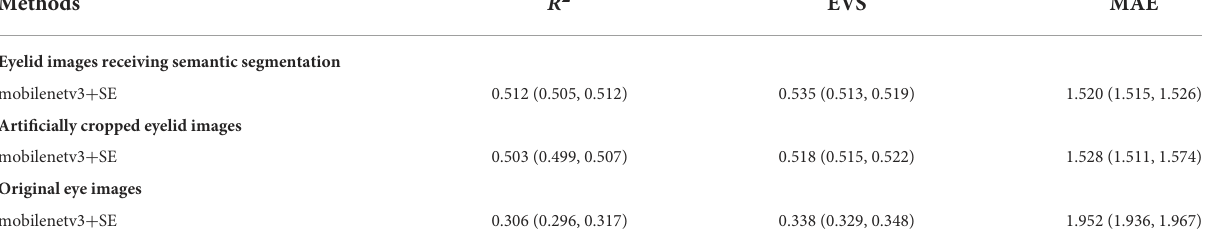
TABLE 4 Ablation experiment results with 95% confidence